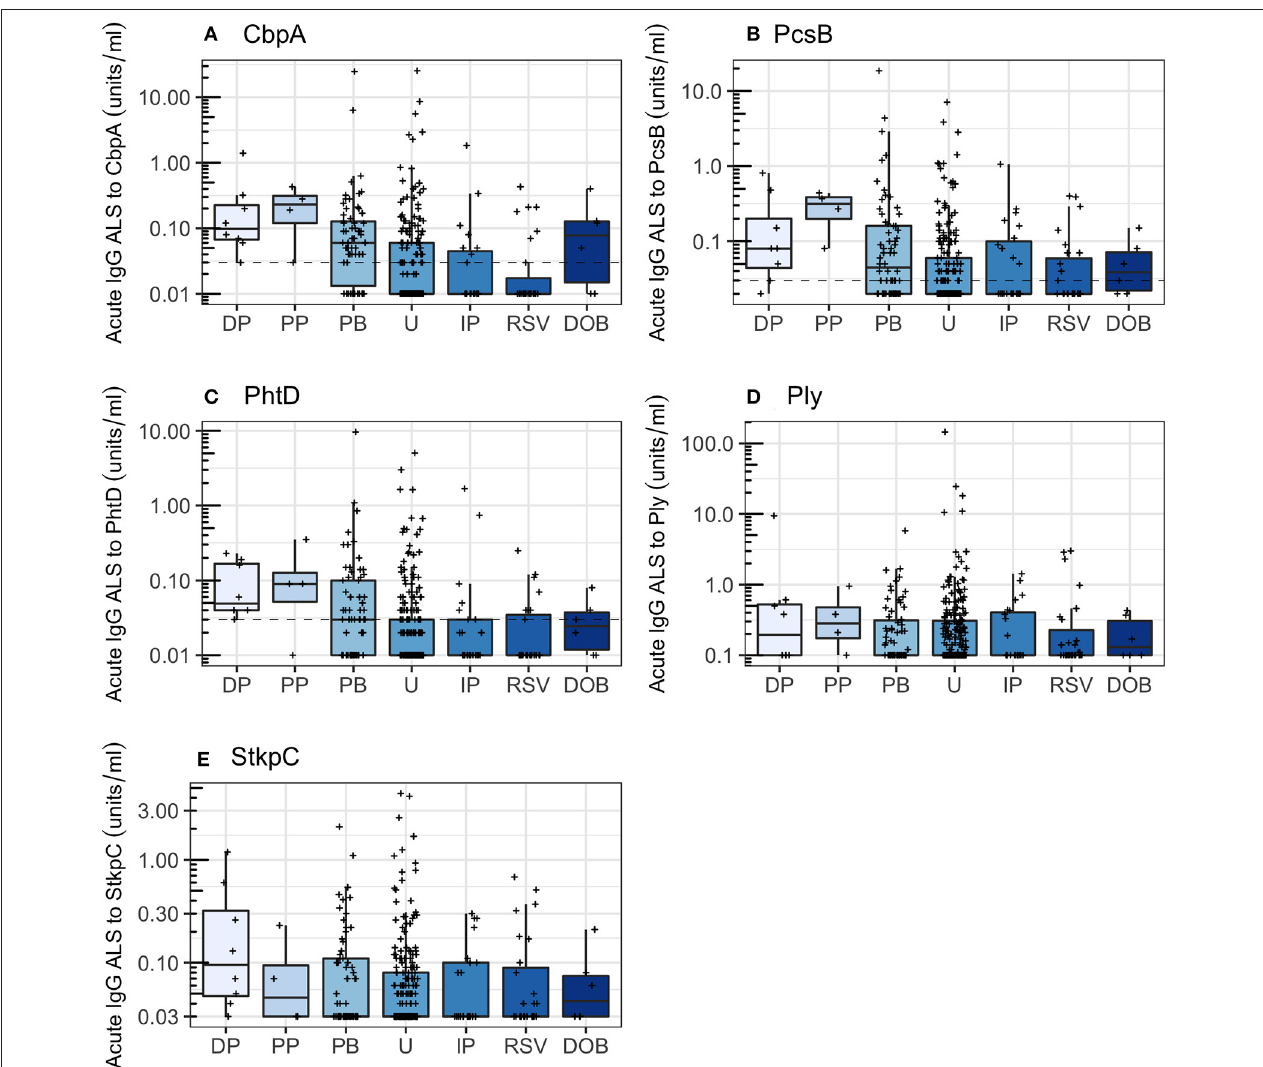
FIGURE 5 | Acute IgG ALS to pneumococcal proteins by comparator group in all children enrolled into the study. Dotted horizontal lines represent thresholds derived from the Youden Index. DP, definite pneumococcal ; PP, probable pneumococcal ; PB, probable bacterial ; U, unknown ; IP influenza/parainfluenza virus ; RSV, respiratory syncytial virus ; DOB, definite other bacterial pneumonia . Dashed horizontal lines represent thresholds derived from the Youden Index. (A) Choline binding protein A (CbpA); (B) protein for cell wall separation of group B streptococci (PcsB); (C) pneumococcal histidine triad D (PhtD); (D) pneumolysin (Ply); (E) serine threonine kinase protein C